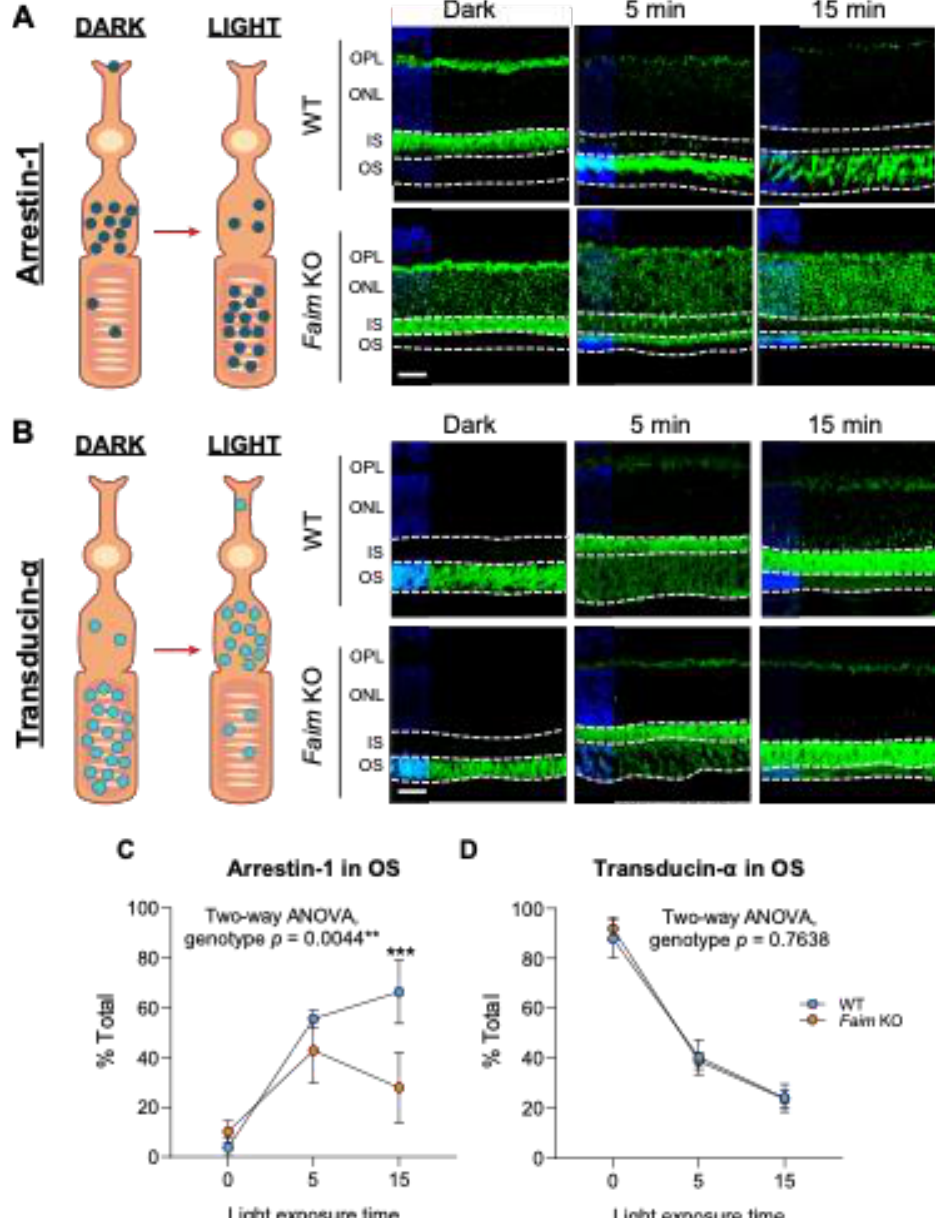
Figure 6. Light-dependent Arrestin-1 and Transducin- α translocation upon light reception. Diagrams representing the translocation of Arrestin-1 ( A , left ) and Transducin- α ( B , left ) from dark-adapted to light-exposed retinas. Representative images of retinal sections immunostained for Arrestin-1 ( A , right ) or Transducin- α ( B , right ) after dark-adaptation and 5 or 15 min of light stimulation. Nuclei were stained with Hoechst (blue). ( C , D ) Quantification of the total of Arrestin-1 and Transducin- α immunostaining in the OS relative to the total of the expression in photoreceptor segments, respectively. Arrestin-1 translocation in Faim KO mice was impaired in comparison to WT mice ( C ), but Transducin- α translocation remained normal ( D ). N = 4 mice per group. Data are represented as mean and SD and represented as total % of protein translocated in the outer segment (OS) per time of light exposure. Two-way ANOVA and Sidak’s post-hoc test was performed. *** p < 0.005. OPL: outer plexiform layer, ONL: outer nuclear layer; IS: inner segment; OS: outer segment. Scale bar: 20 μm. ** p < 0.01,